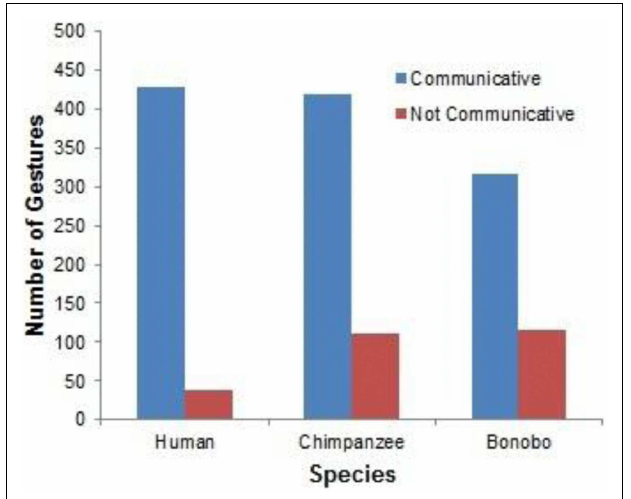
FIGURE 9 |A comparison of communicative (as defined by eye contact, vocalization, or persistence) relative to non-communicative gestures across species.